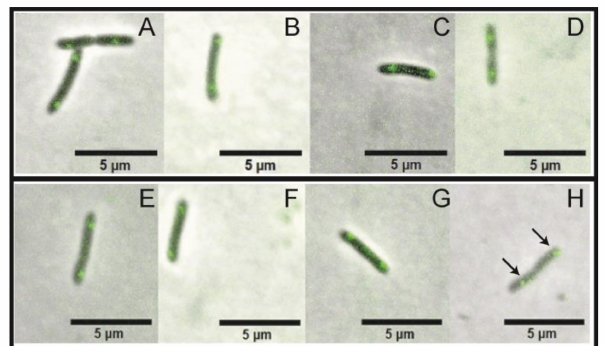
Figure 6. Time-course of X. citri parB-gfp::rbsw showing the localization of ParB-GFP. Absence of theophylline photographed at 4 h, 6 h, 8 h, and 16 h, ( A – D ), respectively. Panels ( E – H ) theophylline was added to the cultures after 4 h of growth, and cells were imaged at the time points of 4 h (T0 of theophylline exposure ( E )), 6 h (2 h of theophylline exposure ( F )), 8 h (4 h of theophylline exposure ( G )) and 16 h (12 h of theophylline exposure ( H )). Scale bar 5 µ m. Magnification 100 × . Merge